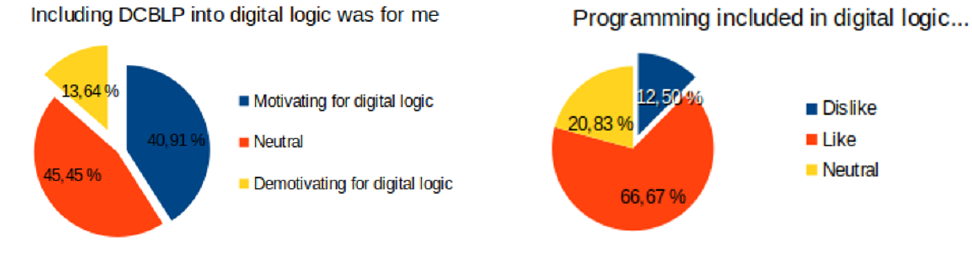
Figure 12. Questions related to motivation for learning digital